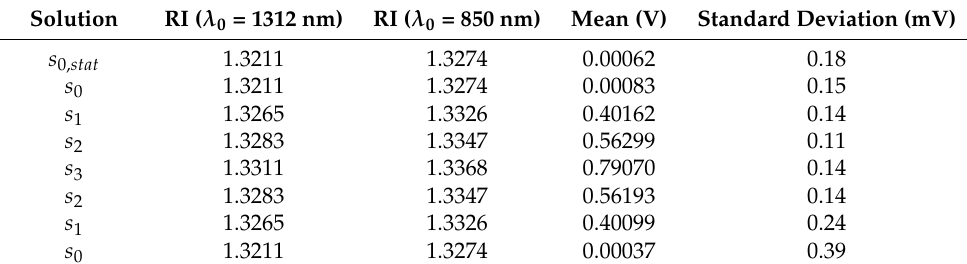
Table 1. Refractive index (RI) at λ 0 = 1312 nm and λ 0 = 850 nm, mean (time-averaged) differential output voltage, and standard deviation over time of the differential output voltage for each solution injected, as measured at the angle of incidence θ l (left working point, Figure 5). The RI at λ 0 = 850 nm were calculated using the dispersion coefficients of water and glycerol and the Sellmeier dispersion equation reported in [33].